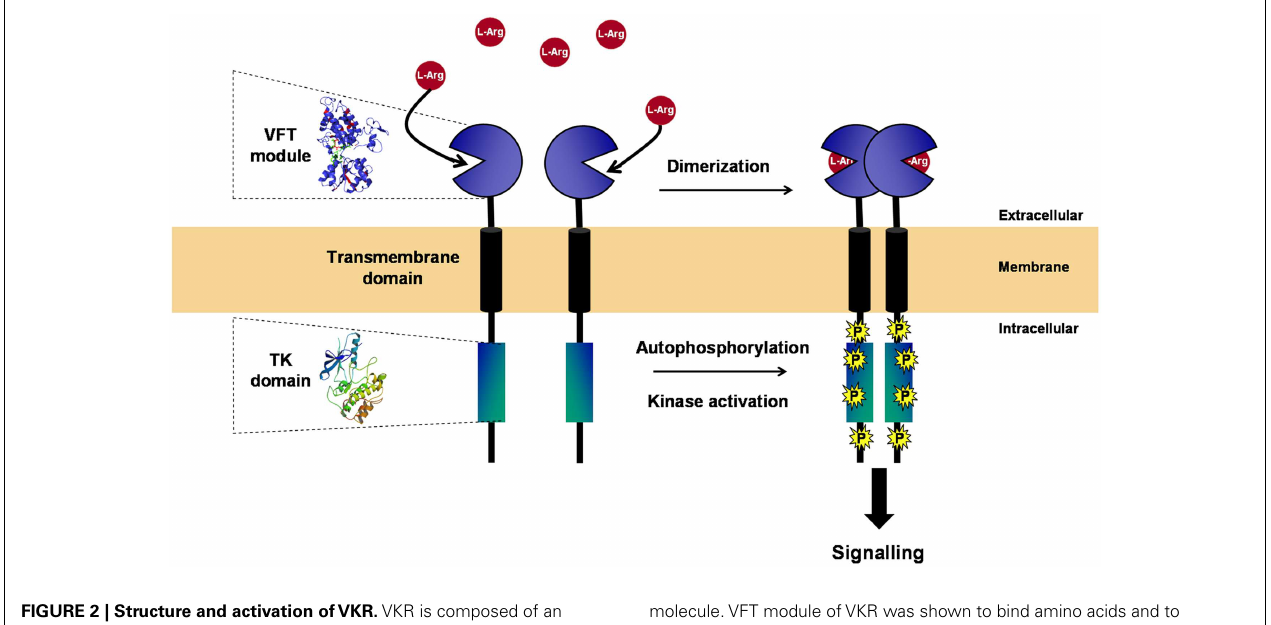
FIGURE 2 | Structure and activation ofVKR. VKR is composed of an intracellularTK domain similar to that of insulin receptor linked by a unique transmembrane domain to an extracellular moiety containing a venus fly trap (VFT) module.VFT domains are formed by two lobes separated by a highly flexible cleft, allowing the binding of a small